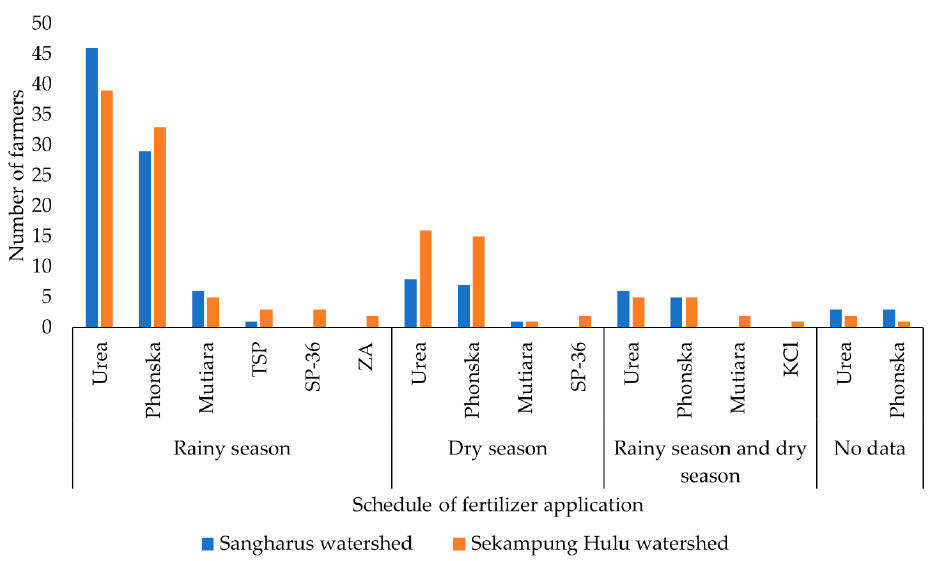
Figure 5. Seasonal schedule of fertilizer application in the Sangharus and Sekampung Hulu watersheds based on the number of farmers.